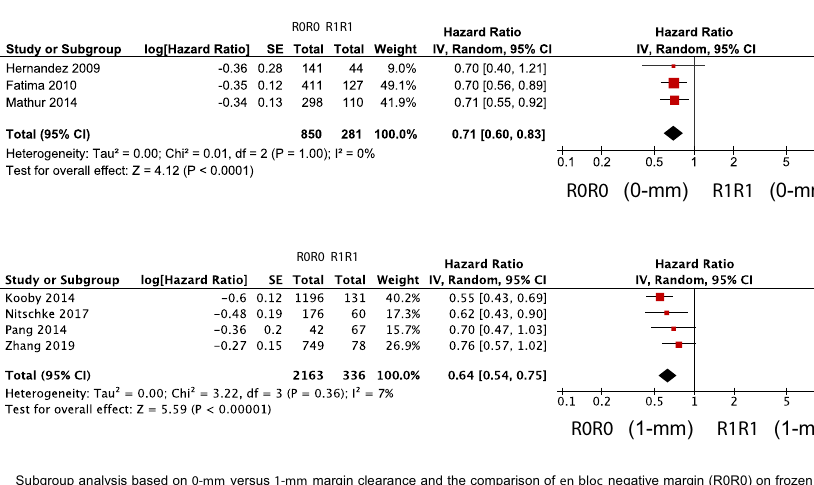
C Subgroup analysis based on 0-mm versus 1-mm margin clearance and the comparison of en bloc negative margin (R0R0) on frozen and finalpathologicalassessment versus positive margin on frozen sectionand final histopathology(R1R1) Figure 3. Subgroup analysis with forest plots comparing overall survival by using a 0-mm and 1-mm margin clearance ( A ) in patients with secondary R0 resection after margin revision (R1R0-group) and en bloc R0-resection (R0R0-group), ( B ) in patients with R0 resection after margin revision (R1R0-group) and residual tumor on final assessment (R1R1-group), and in patients with en bloc R0-resection (R0R0-group) and residual tumor on final assessment (R1R1-group) . An inverse variance random effects model was used for meta-analysis. Squares and horizontal bars indicate point estimate (hazard ratios) with 95% CI for the individual